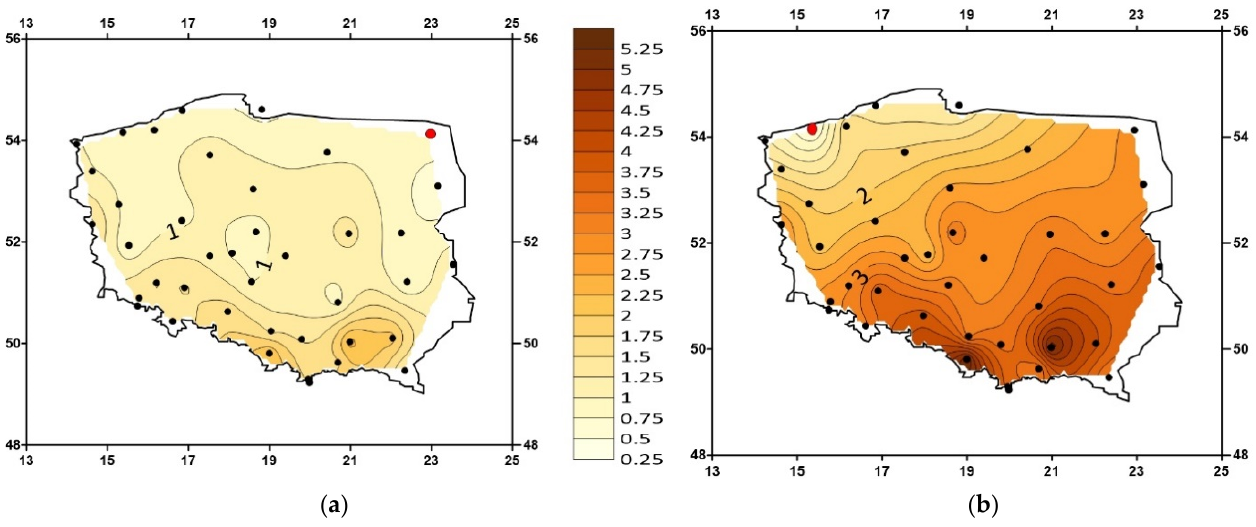
Figure 4. Linear trend coefficient in days/year of frequency of hot days in Poland: ( a ) in the period 1951–2019; ( b ) in the period 1980–2019. Red dots indicate points where trend is not significant at 0.05 level.